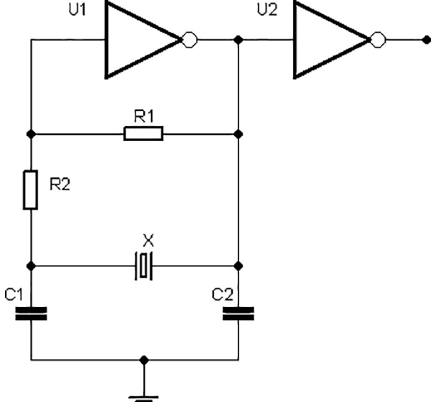
Figure 4. Circuit diagram of a Pierce oscillator circuit.